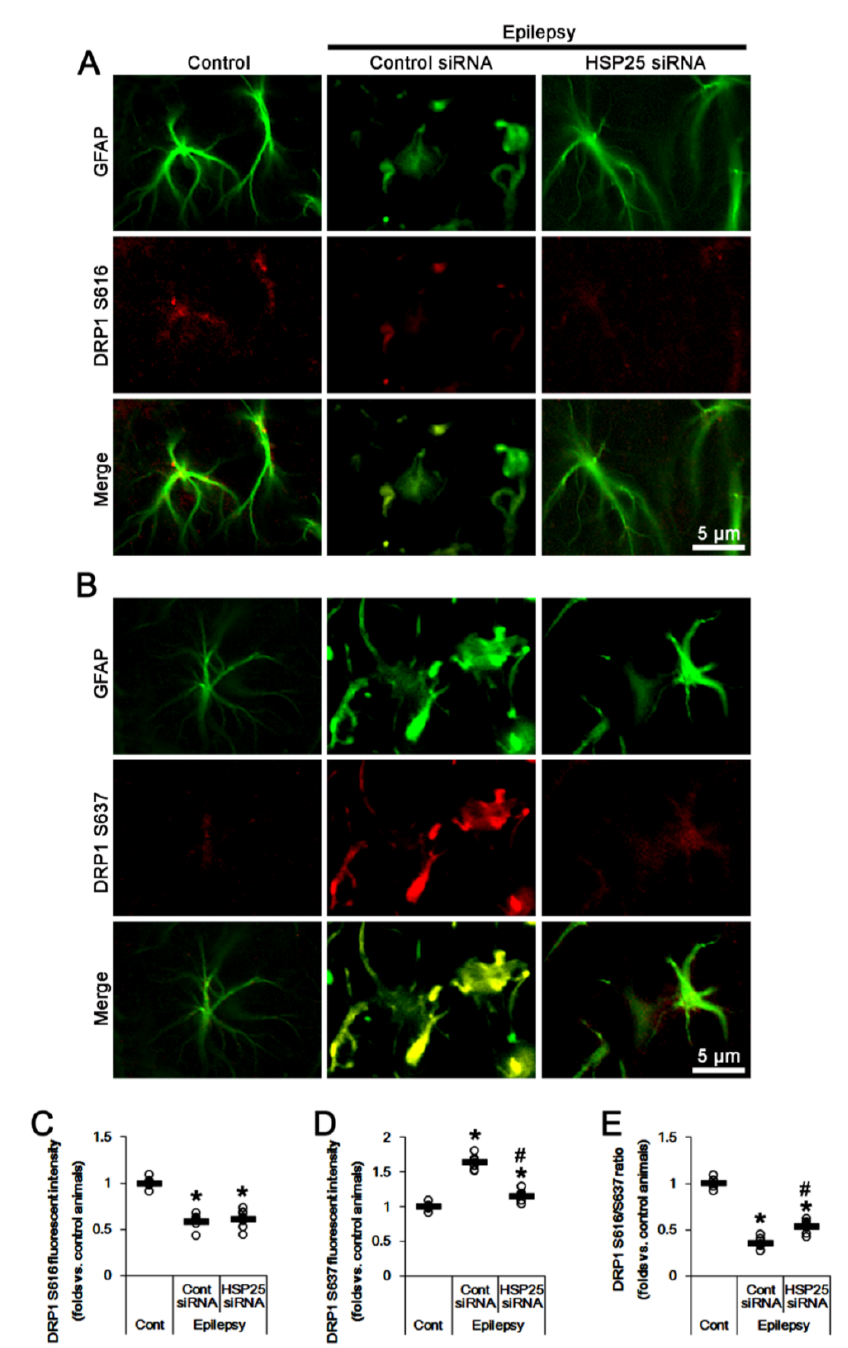
Figure 6. Effects of HSP25 knockdown on DRP1 S616- and S637 phosphorylations in CA1 astrocytes of control and epileptic rats. As compared to control animals (Cont), DRP1 S616 phosphoryla- tion is reduced in CA1 astrocytes in epileptic rats, while DRP1 S637 phosphorylation is increased. CDDO-Me reduces the increased DRP1 S637 phosphorylation in CA1 astrocytes without affecting DRP1 S616 phosphorylation, as compared to control siRNA (cont siRNA). ( A , B ) Representative photos demonstrating astroglial DRP1 S616- ( A ) and S637 phosphorylation ( B ) in CA1 astrocytes. ( C – E ) Quantifications of DRP1 S616- ( C ), S637 phosphorylation ( D ) and DRP1 S616/S637 phospho- rylation ratio ( E ) in CA1 astrocytes. Open circles indicate each value. Horizontal bars indicate the mean value. Error bars indicate SEM (*, # p < 0.05 vs. control and control siRNA-treated epileptic rats, respectively; n = 7,